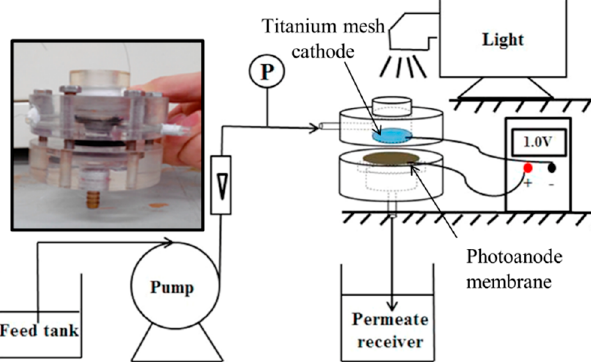
Figure 21. Experimental set-up, insert photo of the reactor. (Adapted with permission from [89]: Wang, X.; Wang, G.; Chen, S.; Fan, X.; Quan, X.; Yu, H. Integration of membrane filtration and photoelectrocatalysis on g-C 3 N 4 /CNTs/Al 2 O 3 membrane with visible-light response for enhanced water treatment. J. Membr. Sci. 2017 , 541 , 153–161, doi:10.1016/j.memsci.2017.06.046. Copyright (2017), Elsevier (Amsterdam, Netherlands)).